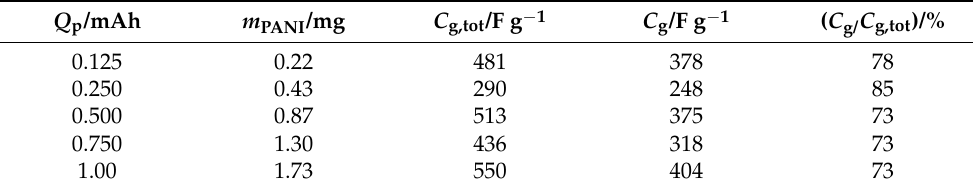
Table 1. Mass, m PANI , specific capacitance in the whole potential region, C g,tot , and in the potential region of emeraldine salt, C g , for an electrochemically formed PANI electrode with different polymerization charges, Q p, at the scan rate of 20 mVs − 1 .